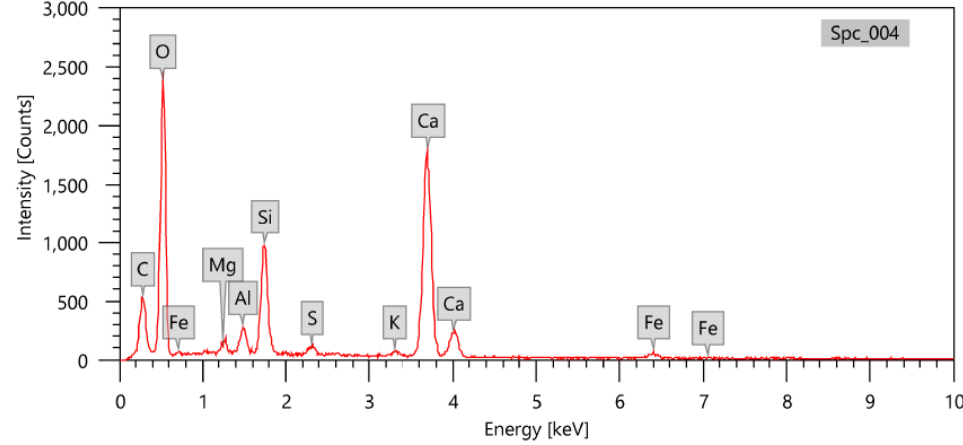
Figure 1. EDX analysis of the used waste marble. Table 2. The composition (%) of the waste marble.